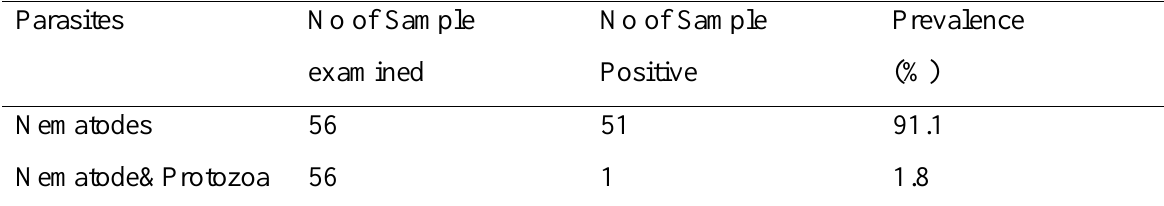
Table 1: The overall prevalence of gastrointestinal parasites of polo horses.